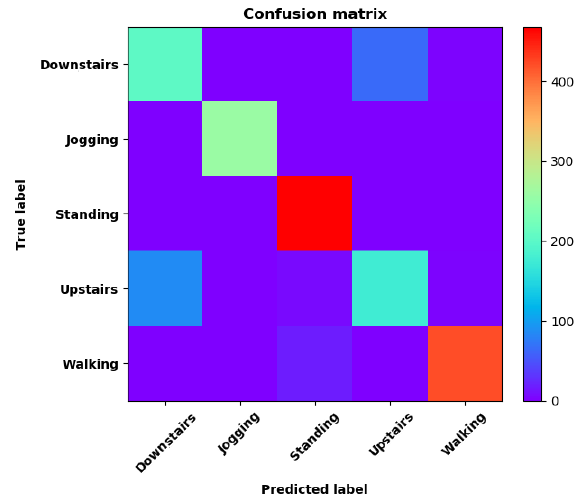
Figure 23. Confusion matrix of classification test using the model trained by CNN network with light measurements.